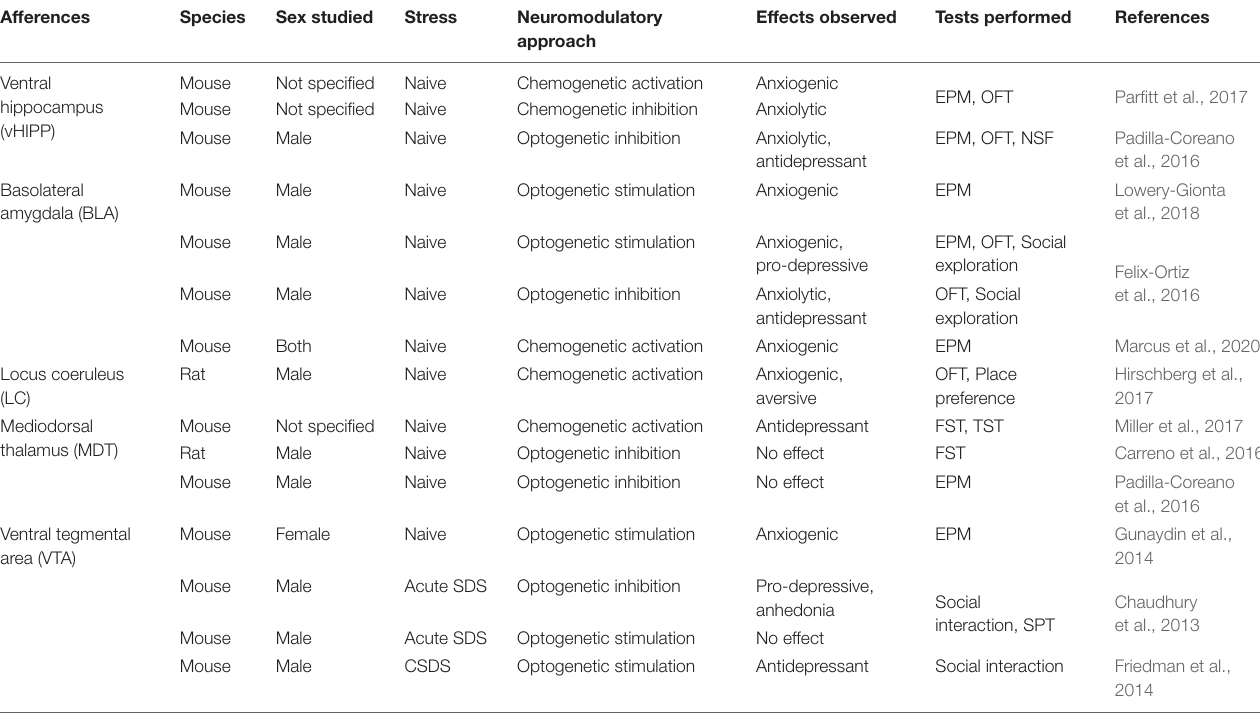
TABLE 1 | Overview of preclinical studies involving mPFC afferences in anxiety-like and depressive-like behaviors.